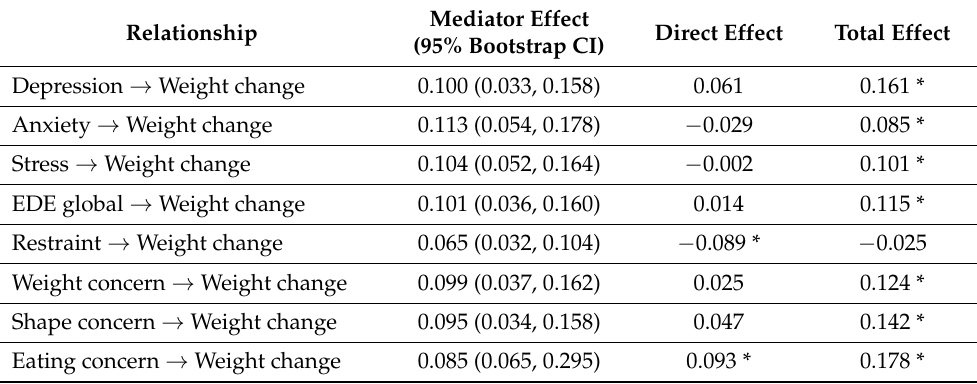
Table 3. Mediator effects of behavioral disengagement in weight gain.